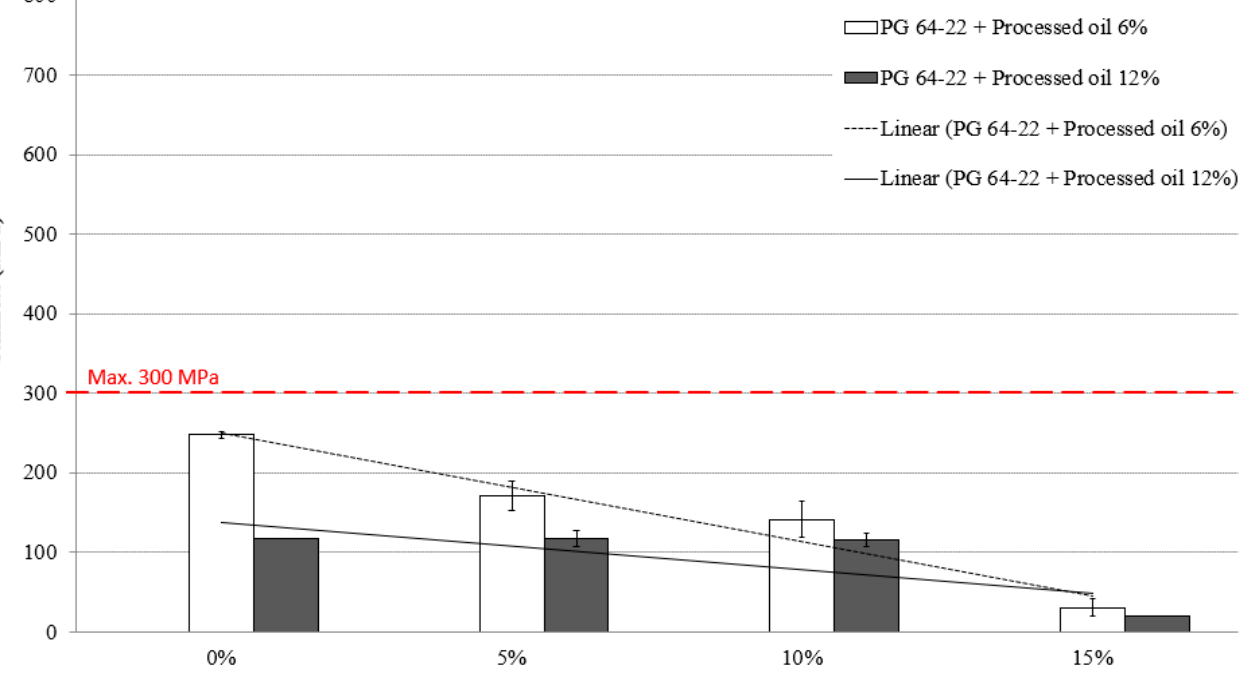
Figure 7. Stiffness of RTFO + PAV aged PG 64-22 binder with processed oil as a function of SBS content at − 12 °C.